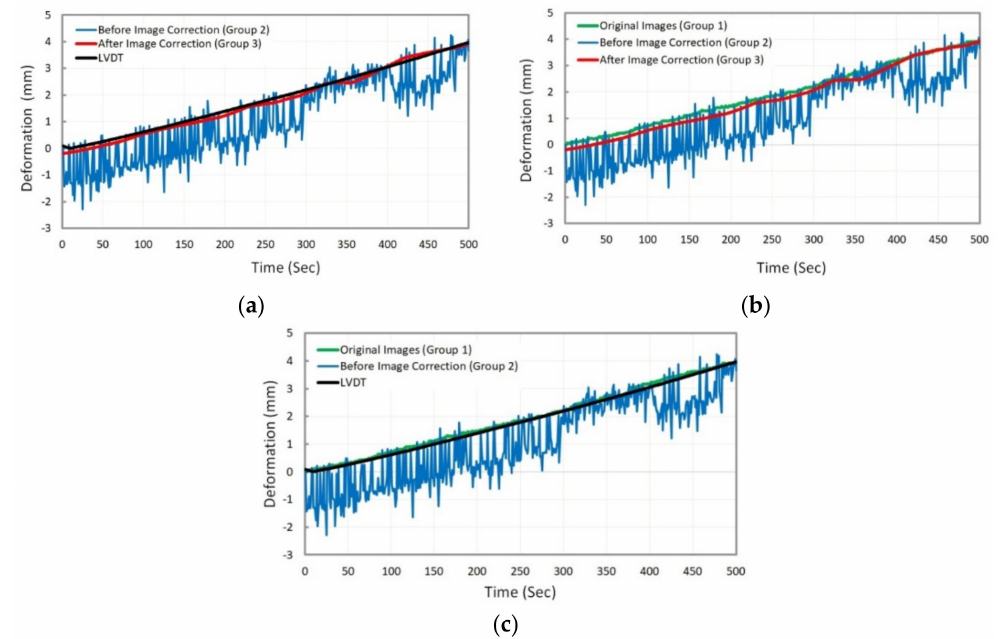
Figure 8. Comparison of deformation results at target G 1 (or natural point) by analysis of three image data